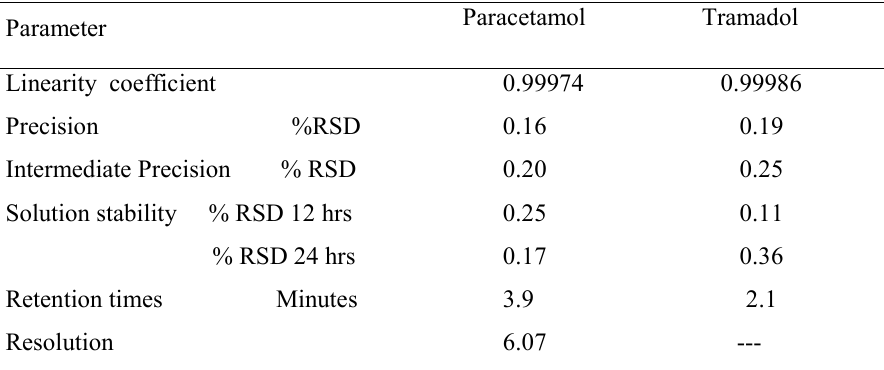
Table 2. Results from Validation of method.